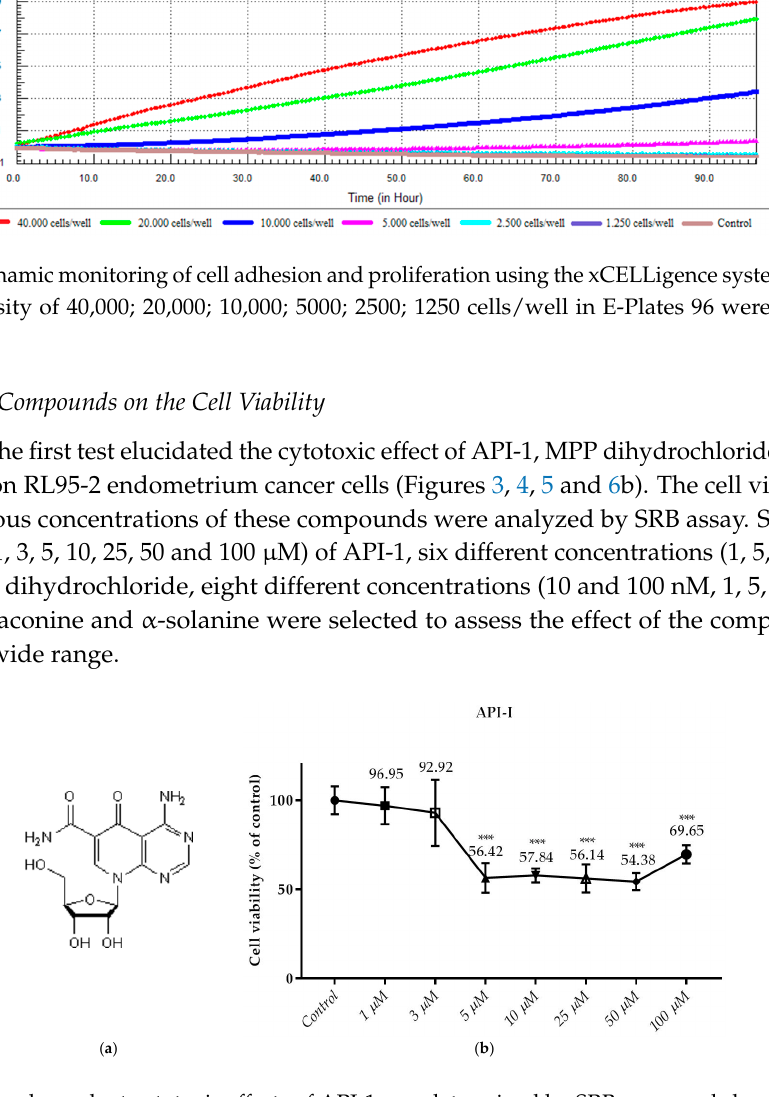
Figure 3. Dose dependent cytotoxic effects of API-1 was determined by SRB assay and shown for 24 h. ( a ) The molecular structure of API-1; ( b ) Effect of API-1 on viability of RL95-2 cell. Cells were